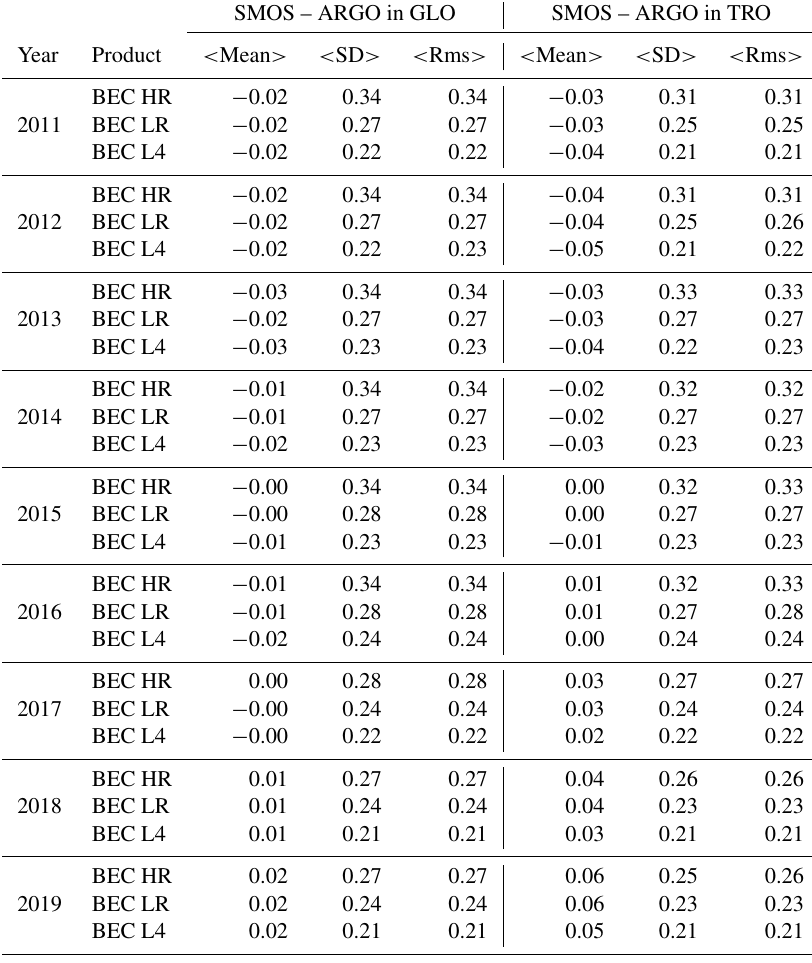
Table 3. Statistics of the comparison of the BEC global SSS product v2.0 with